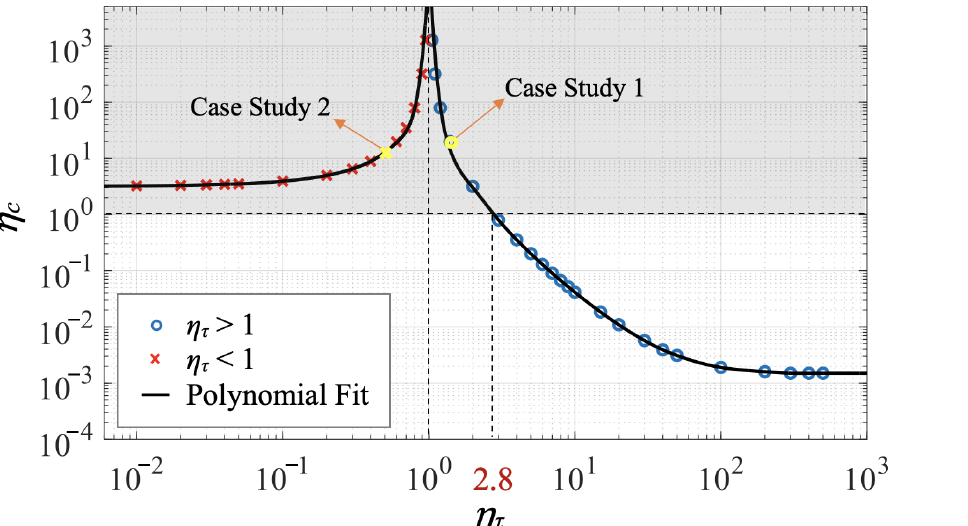
Figure 8. Log-log plot showing the relative total control cost ( η c ) as a function of the normalized inertial response time of the vehicle ( η τ ) for τ m = τ w . Circular and cross markers represent simulations corresponding to different η τ , and the black lines are polynomial fits to these data points. Yellow markers represent the two simulations chosen as case studies in this section. Data points located in the grey shaded area correspond to simulations in which FTC costs less control effort than